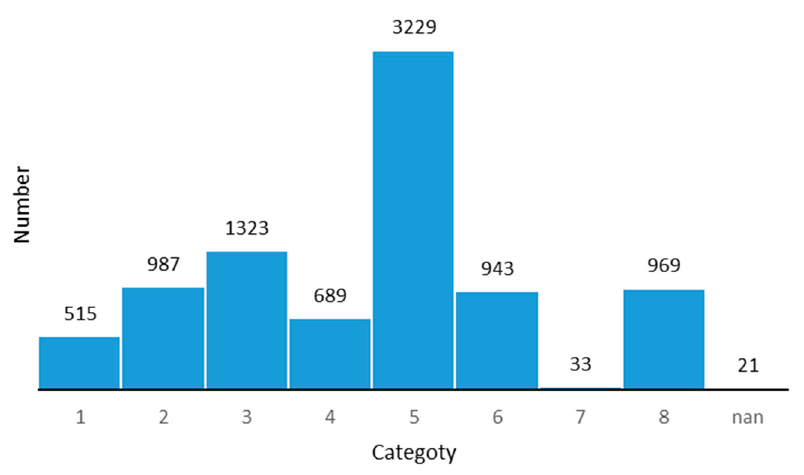
Figure 3. Data distribution in the test set of ITSRB.